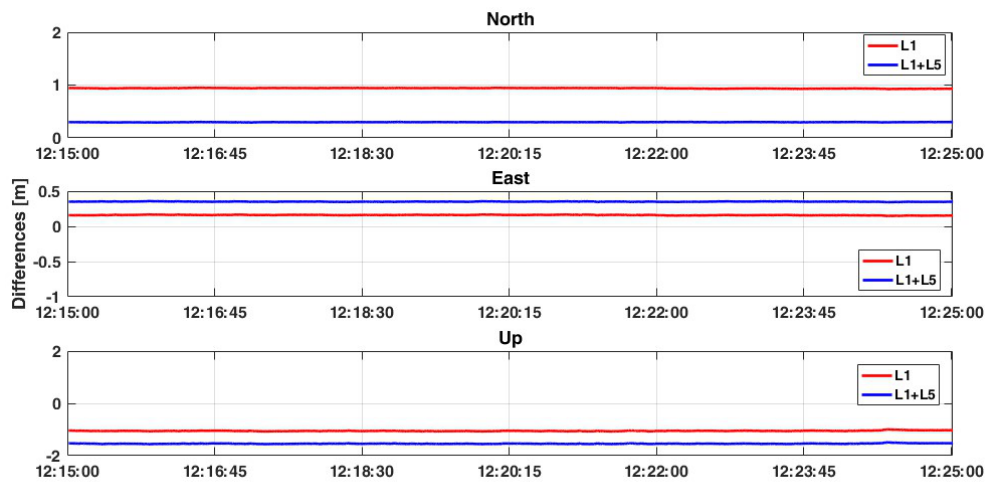
Figure 11. Comparison between L1 and L1+L5 solutions considering GPS+Galileo constellations and ratio